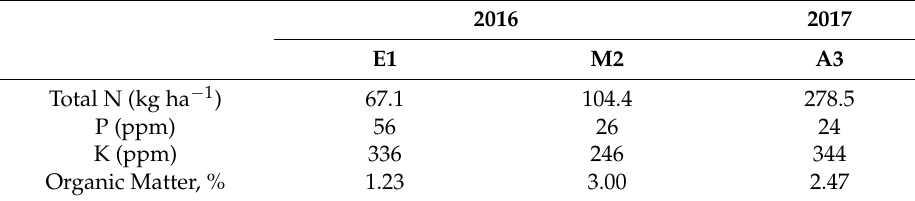
Table 3. Preplant soil test results (0–60 cm).